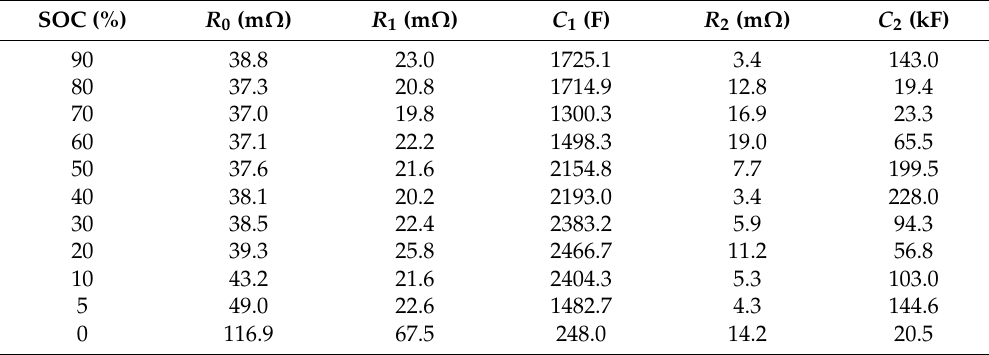
Table 4. Parameters of the 2RC equivalent circuit model under di ff erent